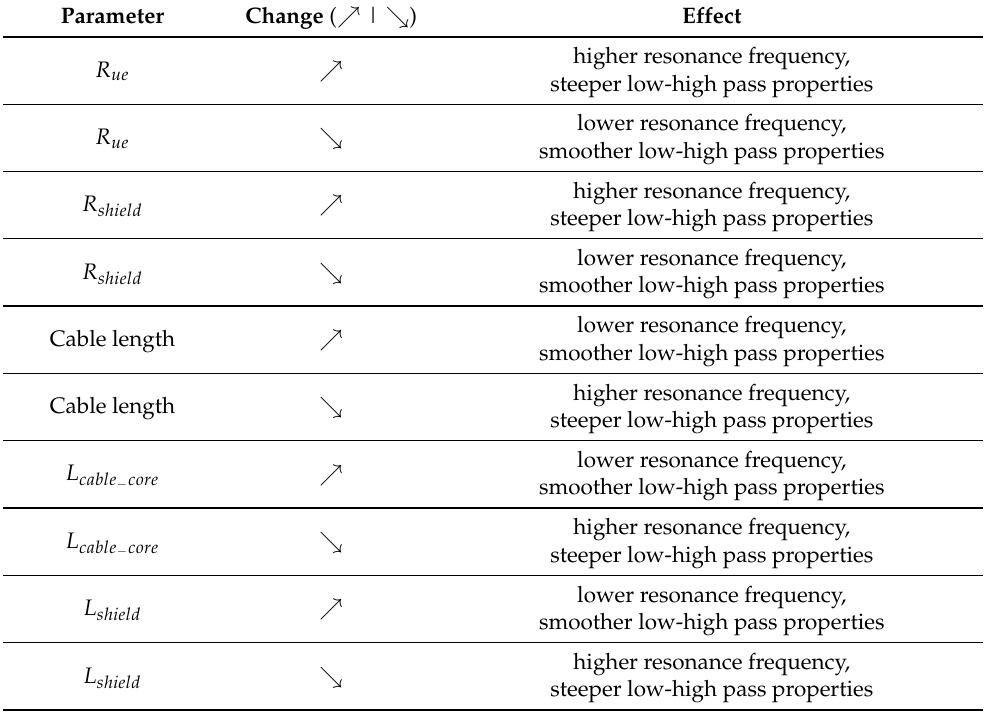
Table 1. Qualitative effect of design parameter changes on shield the current. The analysis is based on the results shown in Figure